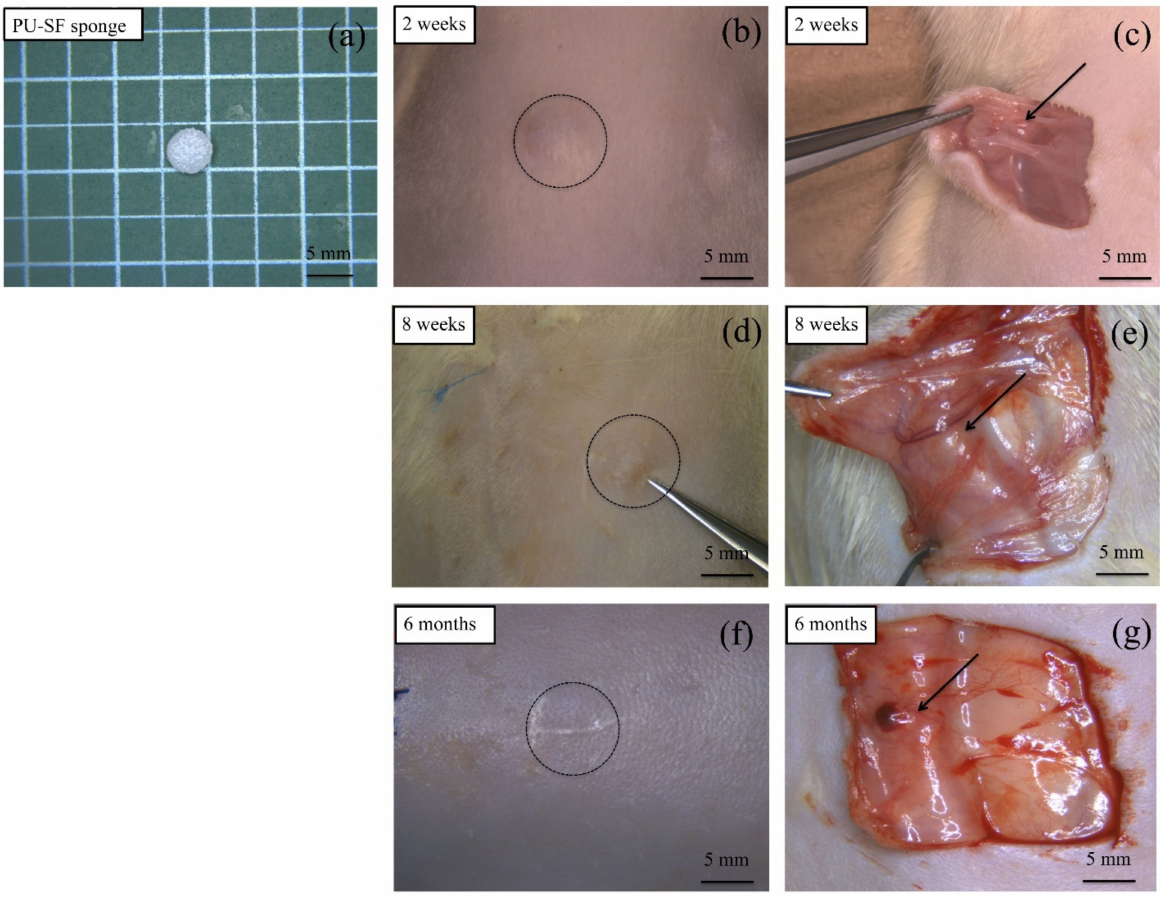
Figure 6. Photographs of the PU-SF sponge ( a ) before and ( b , d , f ) after implantation. Appearance image of the sponge embedding site 2 weeks after implantation ( b ) and appearance image from the inside after skin incision ( c ). Appearance image of the sponge embedding site 8 weeks after implantation ( d ) and appearance image from the inside after skin incision ( e ). Appearance image of the sponge embedding site 6 months after implantation ( f ) and appearance image from the inside after skin incision ( g ).